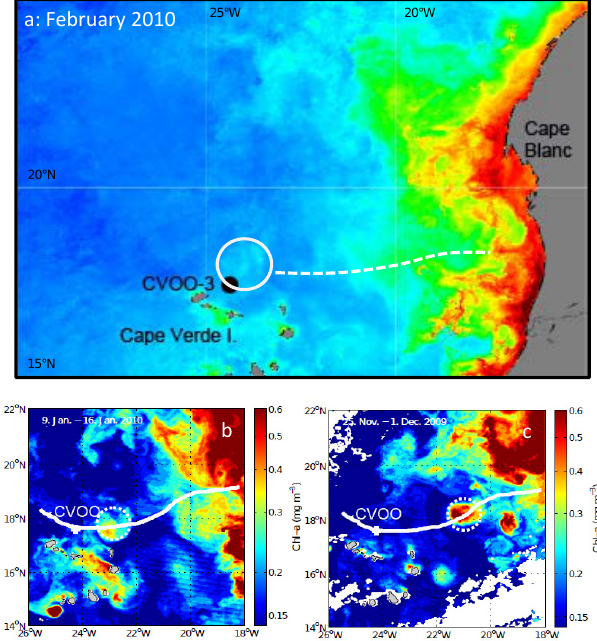
Figure 1. (a) MODIS high resolution chlorophyll picture (4km 2 , L3) with the CVOO time-series site (black circle). Satellite chloro- phyll within the ACME is low in February and hard to see (white circle). The pathway of the eddy from the coast to the CVOO site in summer 2009 is indicated by a white dashed line. (b, c) Satel- lite chlorophyll for November/December 2009 and January 2010 (modified, Karstensen et al., 2015). Chlorophyll decreased between November/December 2009 and January 2010, and again between January and February 2010 within the